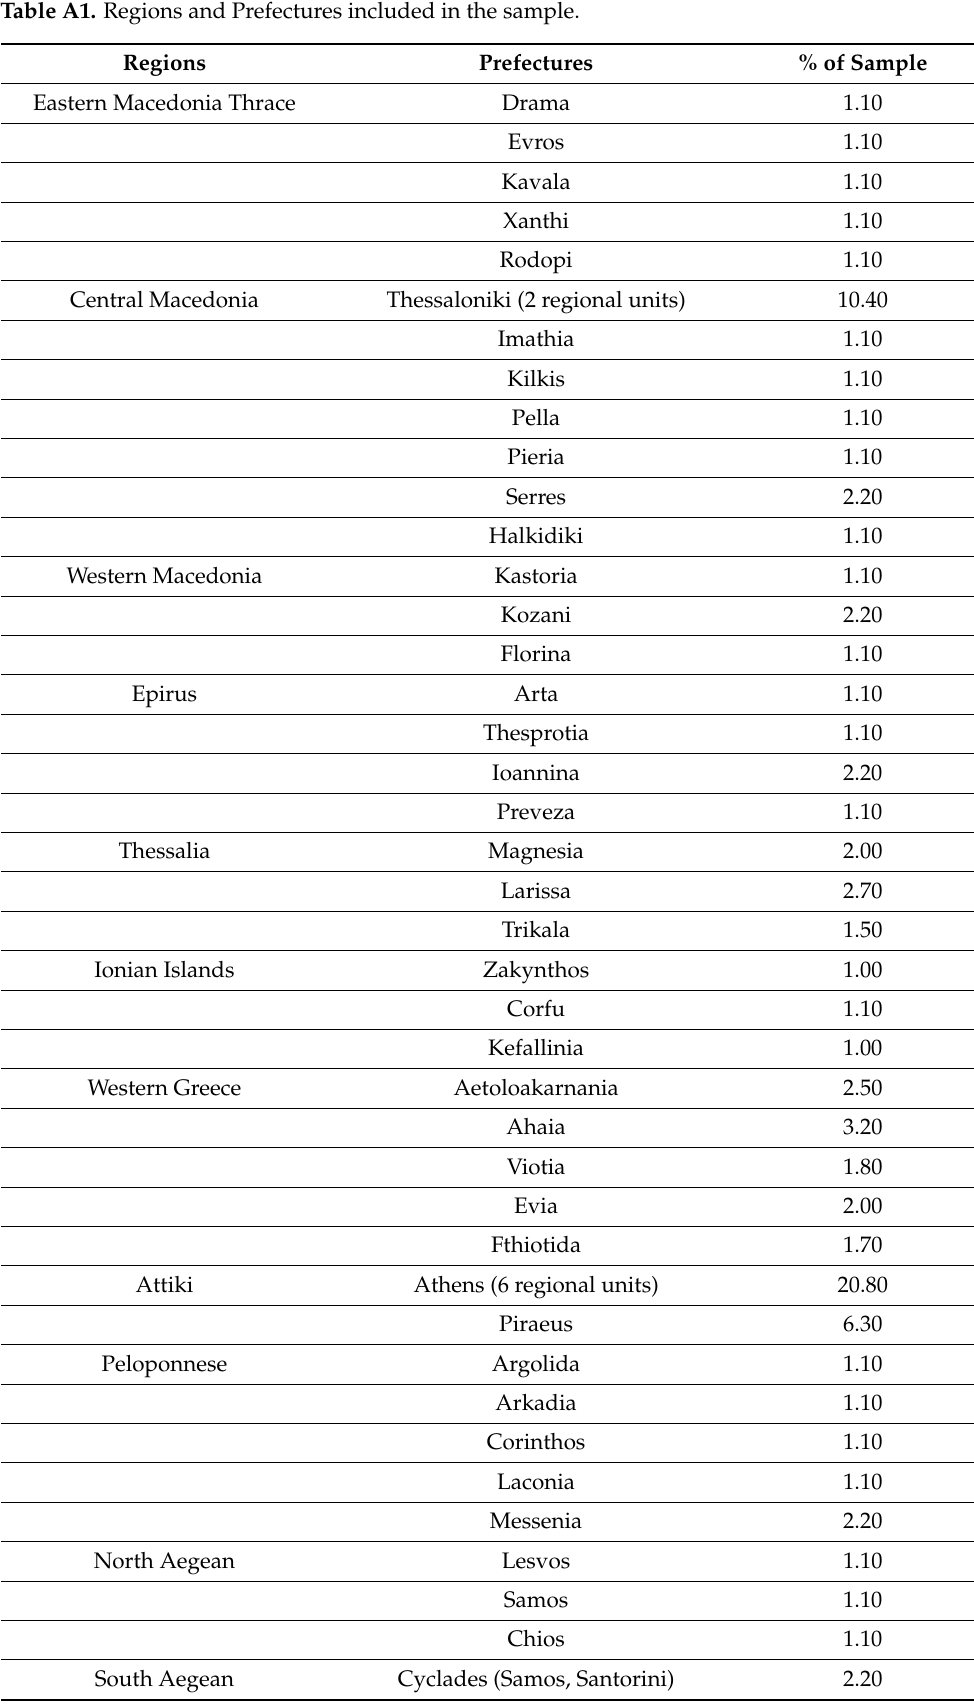
Table A1. Regions and Prefectures included in the